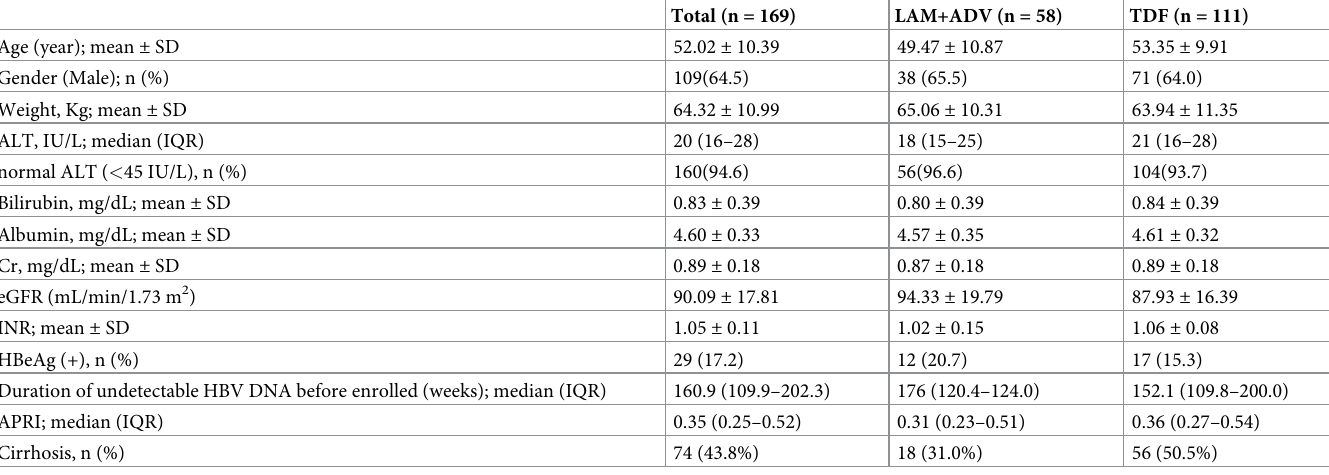
Table 1. Baseline characteristics of